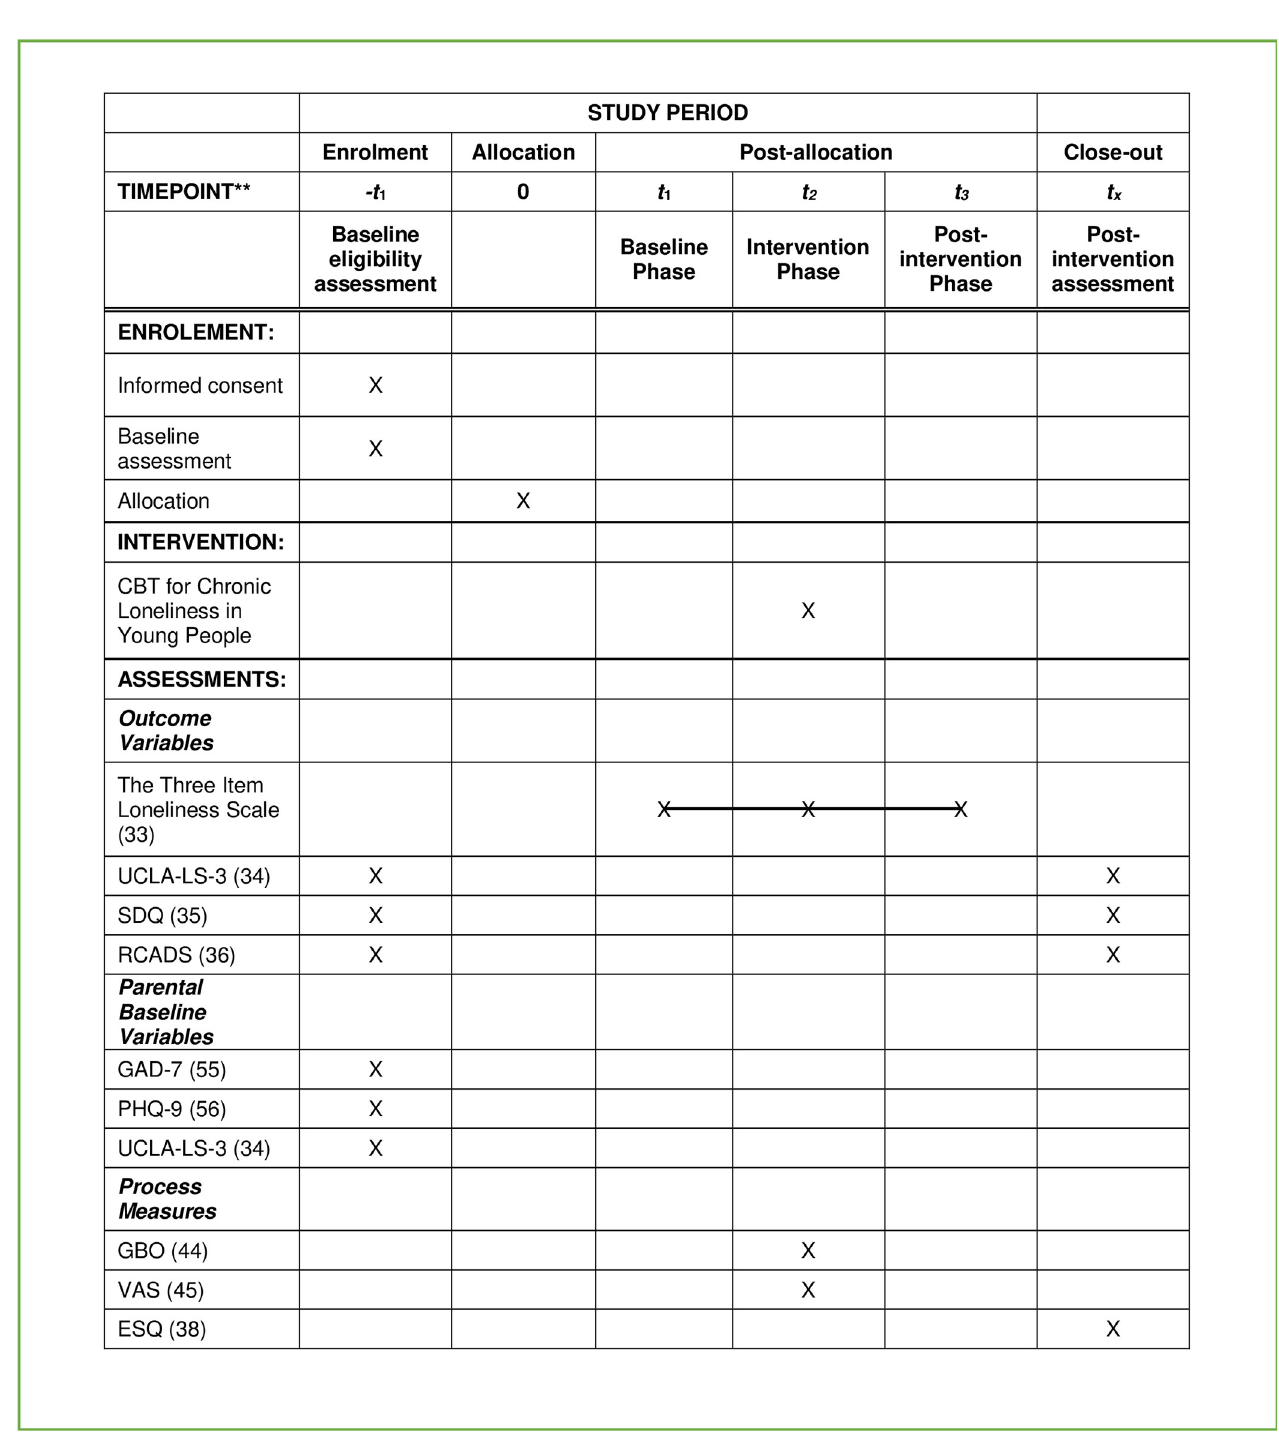
Fig 1. Showing the trials schedule of enrolment, interventions and assessments. how they hope the intervention will reduce their loneliness, which will then guide the treat- ment process. During the intervention phase the participants will complete routine outcome measures (ROMs) for each session. This will include the Three-Item Loneliness Scale [34],